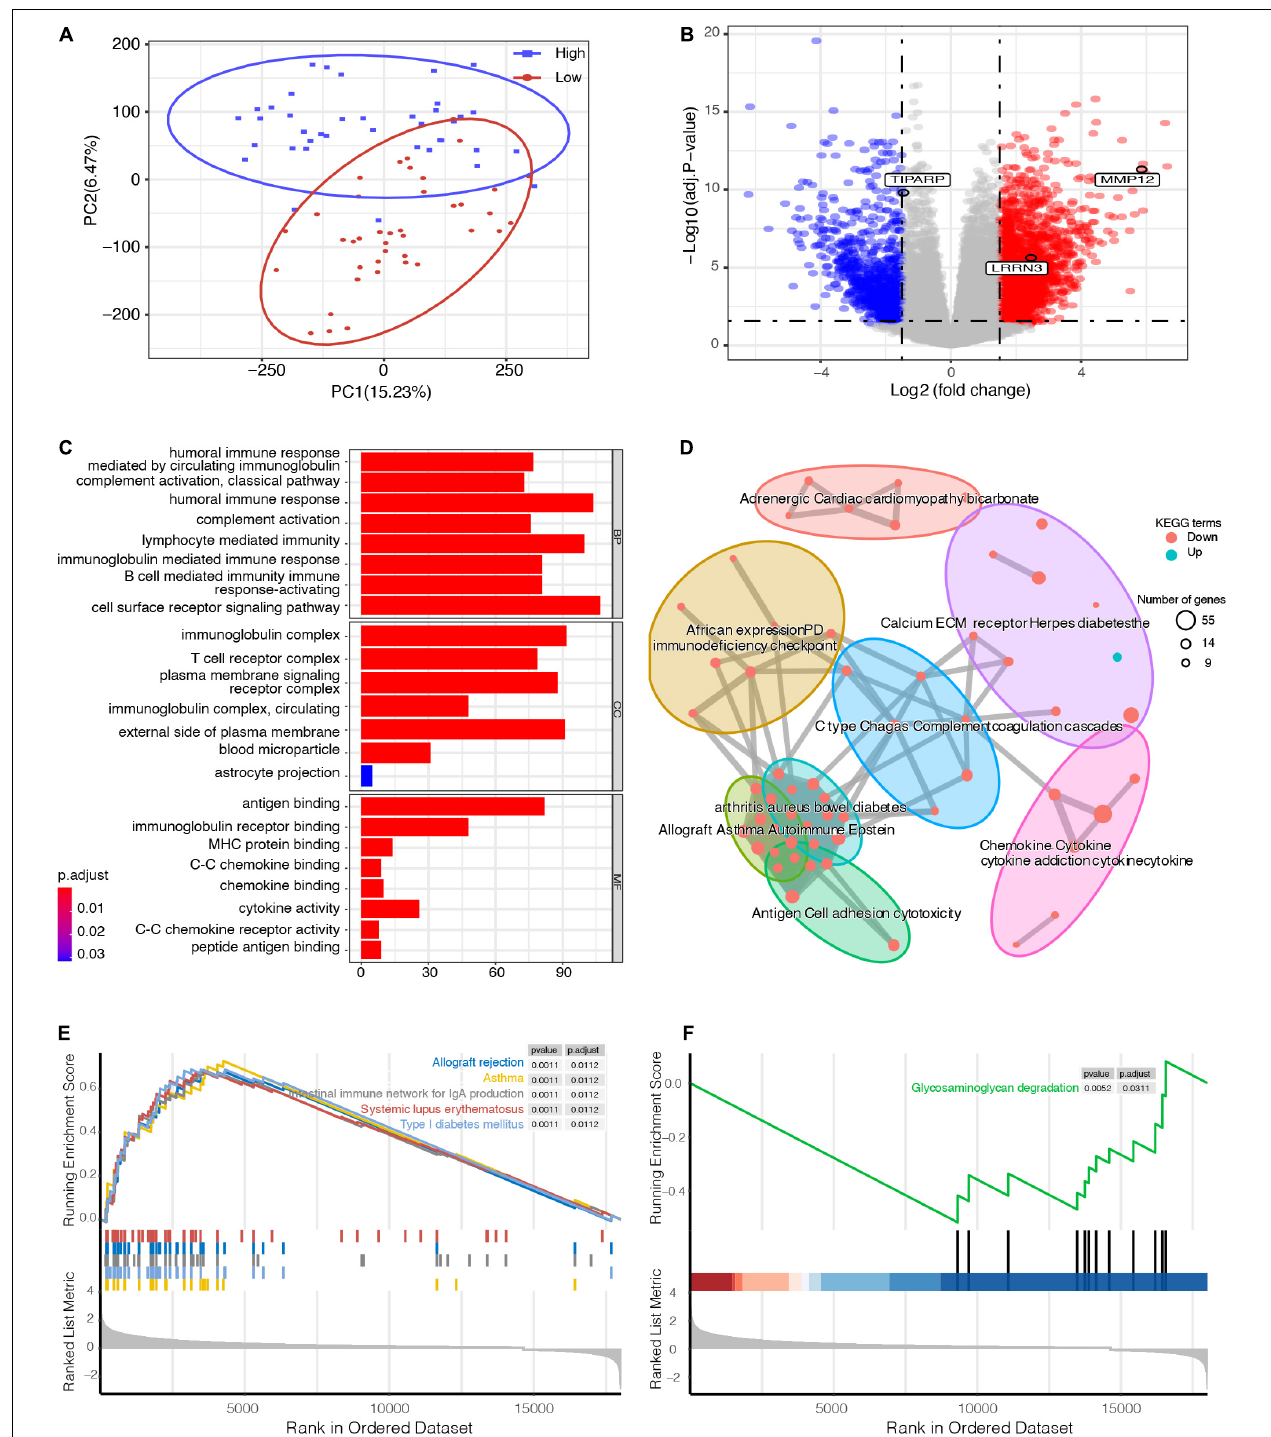
FIGURE 4 | Functional enrichment analysis between high- and low-risk UM groups. (A) principal component analysis (PCA) successfully separated the high- and low-risk UM patients. (B) Volcano plot displaying the differentially expressed genes (DEGs) between the high- and low-risk groups. The log2 (fold change) of TCDD inducible poly (ADP-ribose) polymerase (TIPARP), leucine rich repeat neuronal 3 (LRRN3), and matrix metallopeptidase 12 (MMP12) was –1.46, 2.46, and 5.86, respectively. (C) Gene ontology (GO), (D) Kyoto Encyclopedia of Genes and Genomes (KEGG), and (E,F) Gene set enrichment analysis (GSEA) analyses compared the difference between the high- and low-risk UM